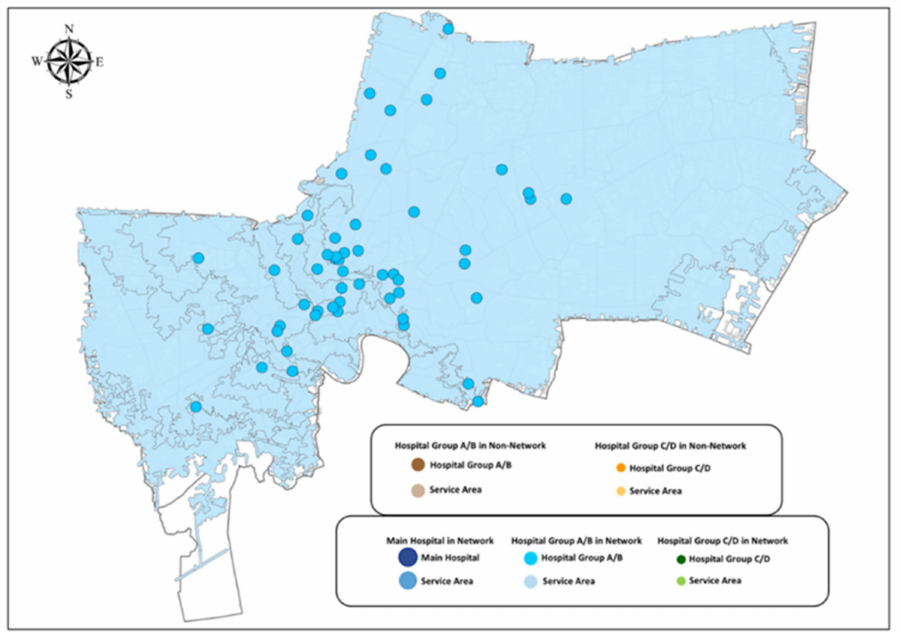
Figure 16. Service area if non-network hospitals in Group A/B were changed to network hospitals. Change All Non-Network Hospitals in Group C/D to Network Hospitals with Patient Transferal to the Nearest Hospital in Group A/B From the current 30 hospitals with networks in Group C/D, the service area covers 427 square kilometers, or 27.20% of the total area in Bangkok. However, if all 58 non- network hospitals in Group C/D can be improved to become network hospitals with stroke patients being transferred to the nearest hospital in Group A/B, the service area would cover 1245 square kilometers, or 79.37% of the total area of Bangkok, as shown in Figure 17.